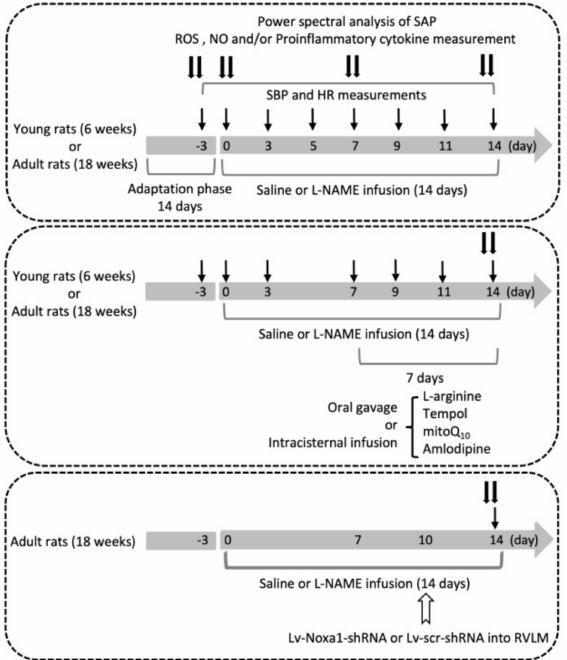
Figure 1. Experimental design of the present study. The first group of young and adult animals ( n = 6 per group) was used to assess systolic blood pressure (SBP), heart rate (HR), and power density of low-frequency component in the SBP spectrum at various time intervals (arrows) before and after i.p. infusion of L -NAME for 14 days. Nitric oxide (NO), reactive oxygen species (ROS), and/or proinflammatory cytokine in plasma and/or tissue of rostral ventrolateral medulla (RVLM) were measured at the end of the 14-day L -NAME treatment (double arrows). The protocol was repeated in a second group of young and adult rats ( n = 5 per group) to evaluate the effect of various treatments, delivered via oral gavage or intracisternal infusion during days 7–14, on L -NAME-induced changes in SBP, HR, LF power, and NO and ROS levels in RVLM. The third group of adult animals ( n = 6 per group) was used to examine the effect of gene silencing NADPH oxidase activator 1 ( Noxa1 ) in RVLM on changes in SBP, HR, LF power, and NO and ROS levels in RVLM induced by systemic L -NAME. Lentiviral vector contains a target-specific construct that encodes a short hairpin RNA (shRNA) to knock down gene expression of Noxa1 (Lv-Noxa1-shRNA) or control scrambled shRNA (Lv-scr-shRNA) was microinjected into the bilateral RVLM (open arrow) on day 10 after L -NAME